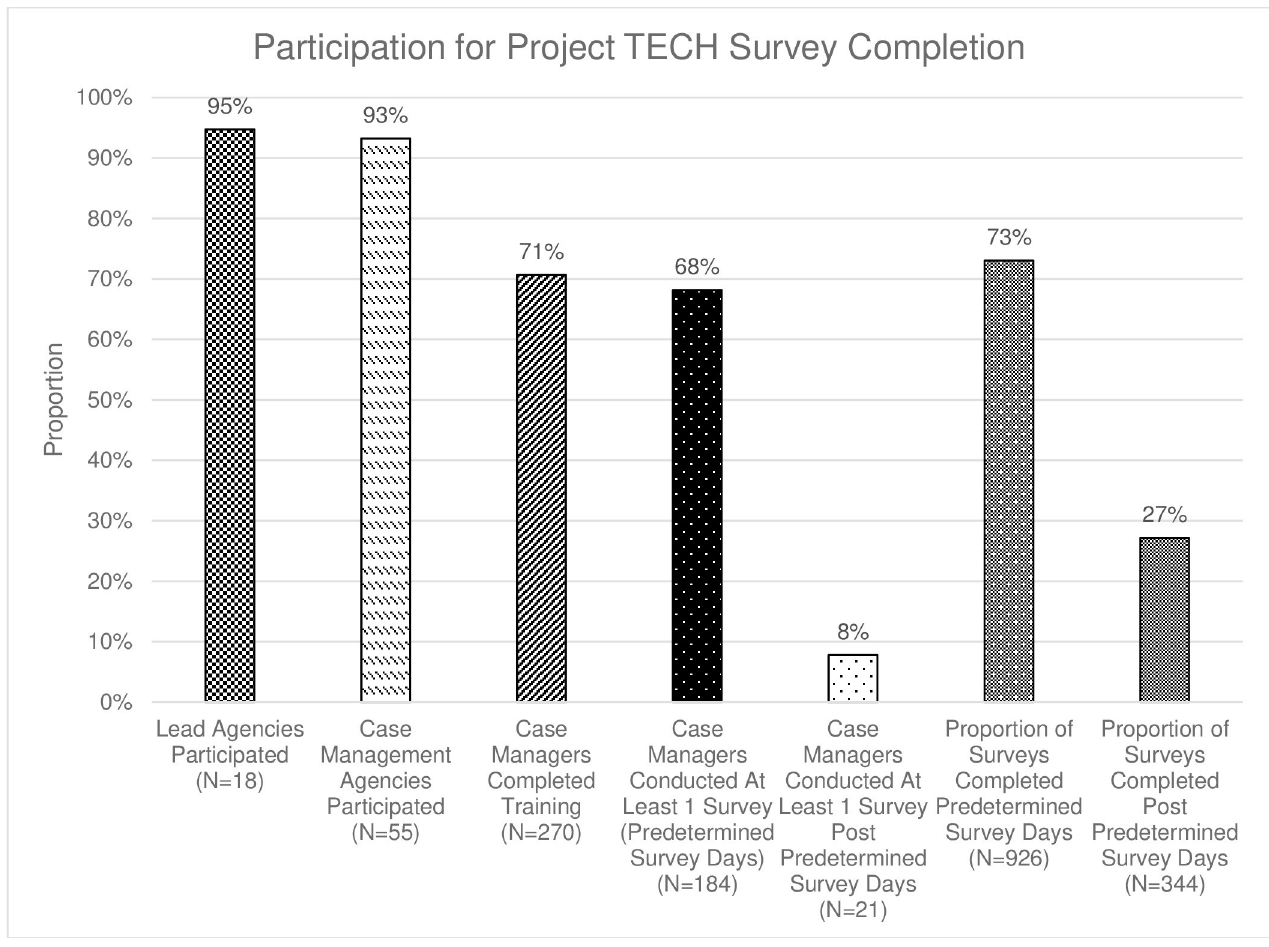
Fig 1. Case manager participation